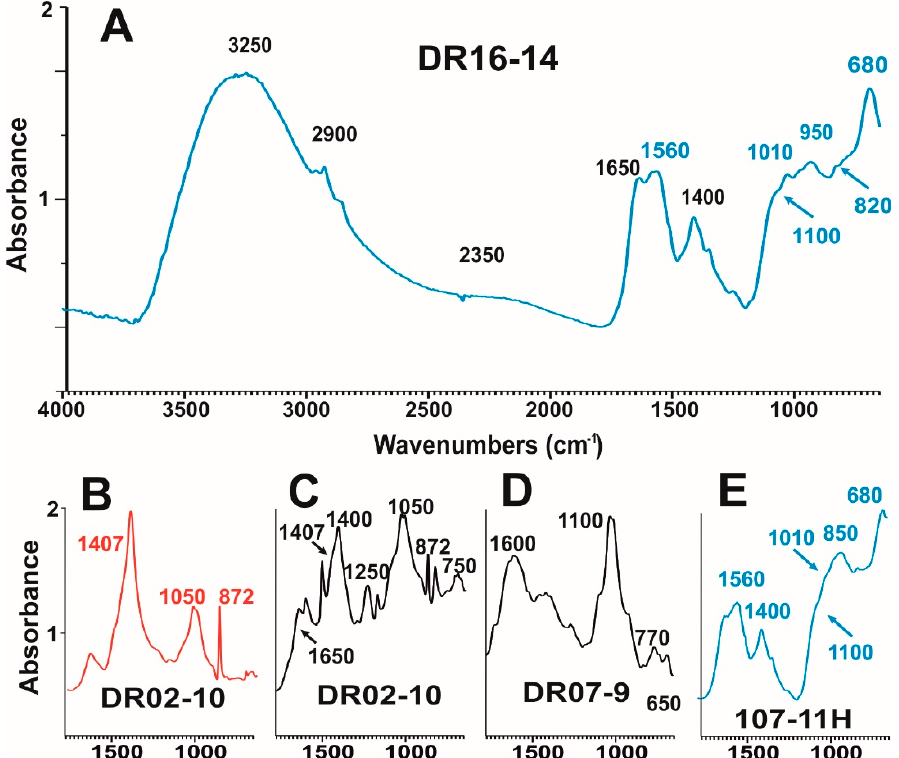
Figure 8. ( A – E ) FT-IR spectra of different Fe-Mn oxyhydroxides laminae of the studied samples. ( A ) general spectra for a hydrogenetic crust with the main absorptions of OH, O–H 3250 cm − 1 , C–O and C–H bands 2900, 2350 and 1560 cm − 1 and hydrogenetic minerals in the range between 1400 and 650 cm − 1 ; ( B – E ) absorption bands of the interesting Mn-oxides and related minerals; ( B ) marked in red absorption bands of the CO 32 − (872 and 1407 cm − 1 ) related to the Ca-rich lamina in DR02-10 and the presence of foraminiphera (Figure 3A) and Mn minerals band 1050 cm − 1 ; ( C ) marked in black diagenetic Mn-oxides enriched in Ca (CO 32 − 872, 1407 cm − 1 ); ( D ) diagenetic Mn-oxides with their typical absorption at 1600, 1100 and 770 cm − 1 ; ( E ) marked in blue hydrogenetic Mn-oxides with their typical absorption at 1010–850 and 680 cm − 1 .